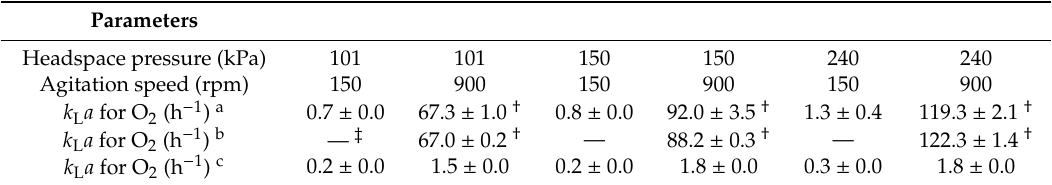
Table 1. E ff ect of headspace pressure and backmixing at 150 and 900 rpm on k L a for O 2 in a non-sparged CSTR with 3 and 5.6 L working